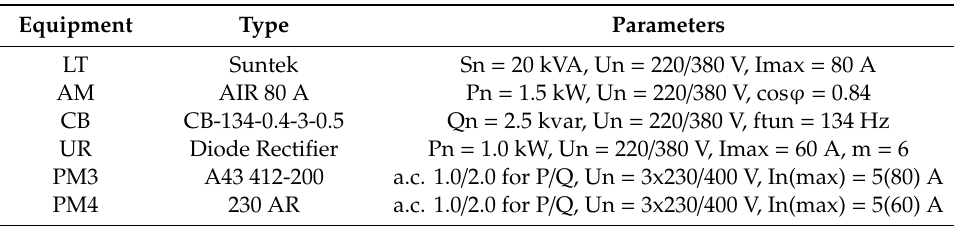
Figure 2. Test bench for harmonic impact research on the metering error. Table 3. The equipment used in the laboratory bench.